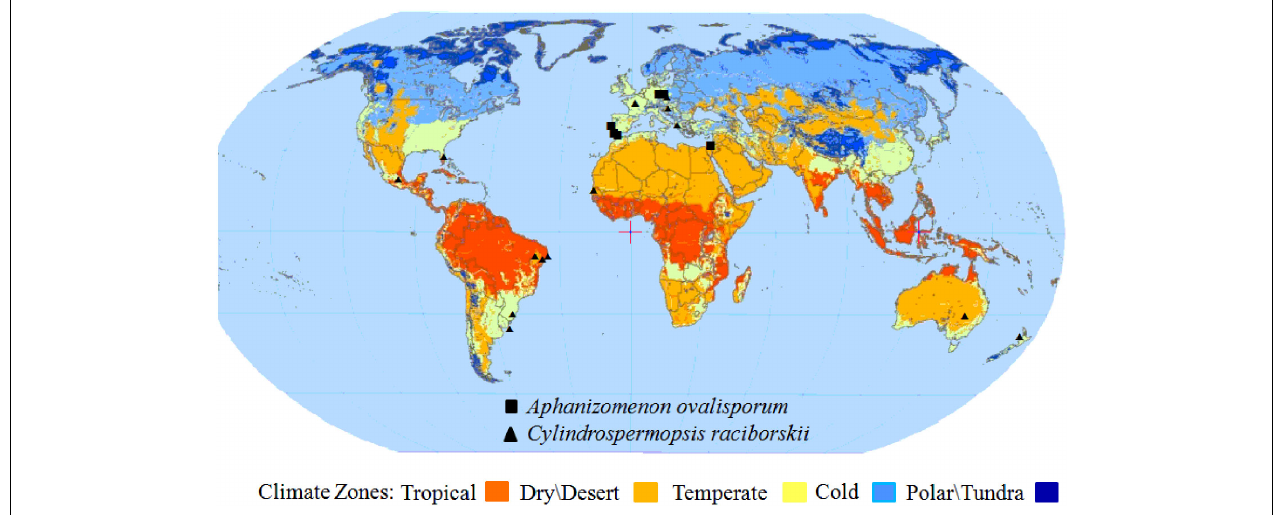
FIGURE 1 |The expansion of the Nostocales Cylindrospermopsis raciborskii (triangles) and Aphanizomenon ovalisporum (squares) to temperate and subtropical regions shown in a world climate zones map. (Map source: